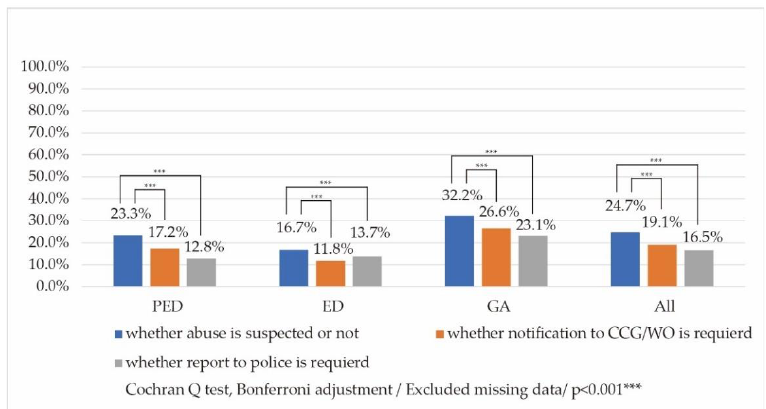
Figure 2. Disagreements among staff regarding the handling of abuse.